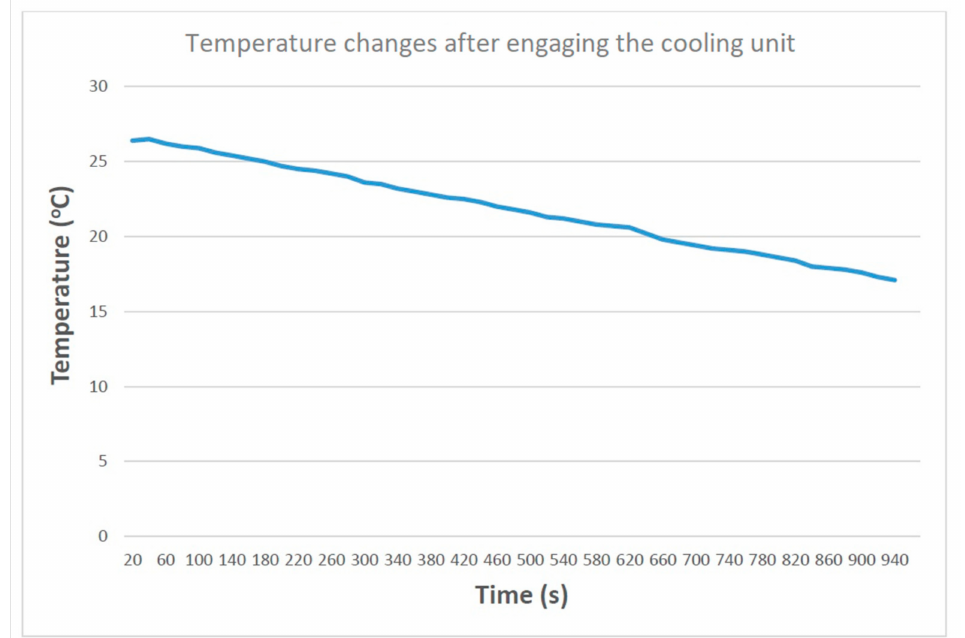
Figure 14. Plot presenting the results of the cooling system’s test